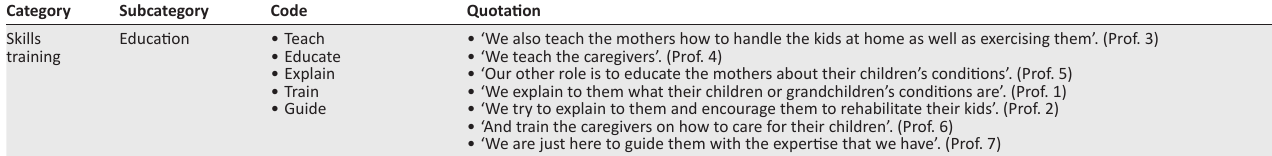
TABLE 4: Role of rehabilitation professionals: Skills